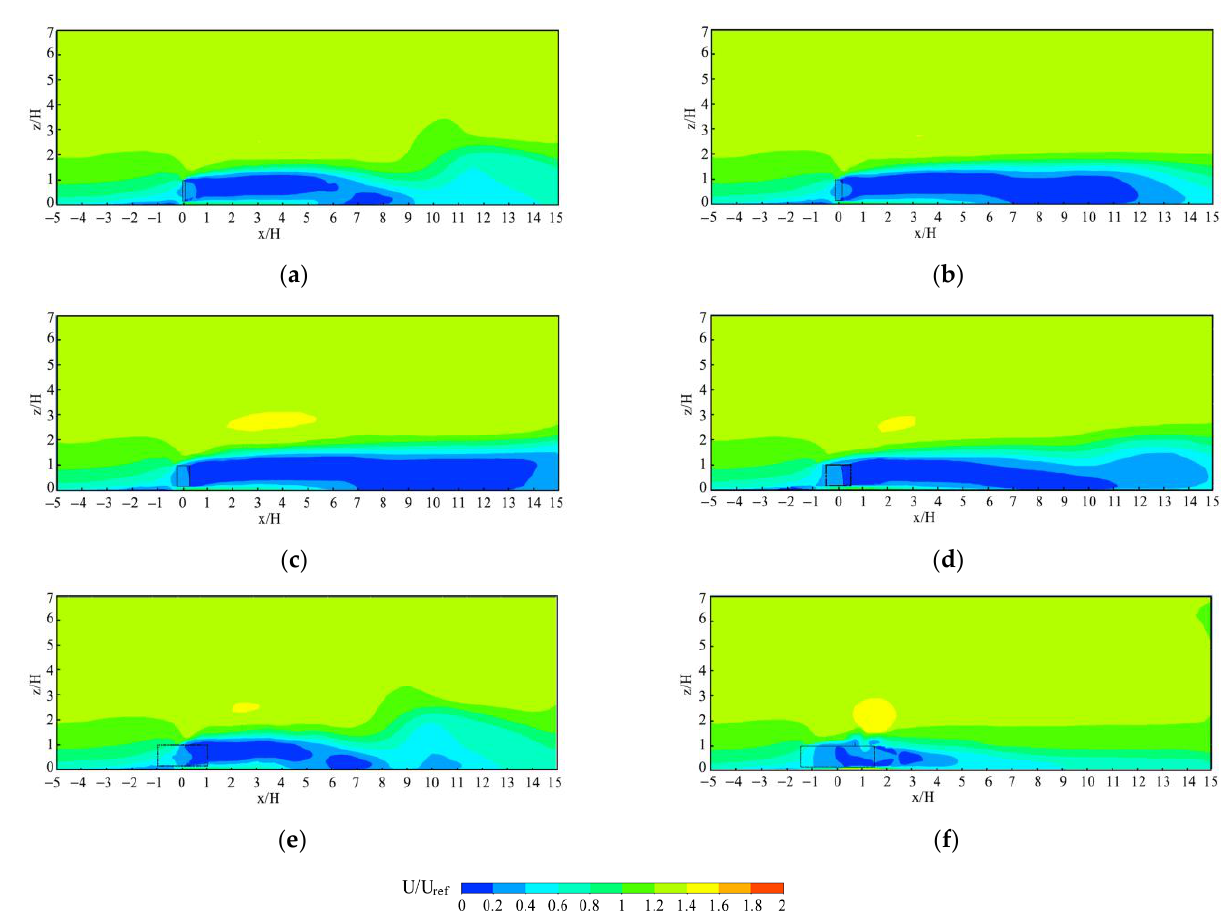
Figure 6. Normalized mean wind speed around the canopy with different widths in cross section of y/H = 0, ( a ) W = 0.1 H, ( b ) W = 0.3 H, ( c ) W = 0.5 H, ( d ) W = 1 H, ( e ) W = 2 H, ( f ) W = 3 H. The dotted line rectangular marks the canopy region occupied by trees.